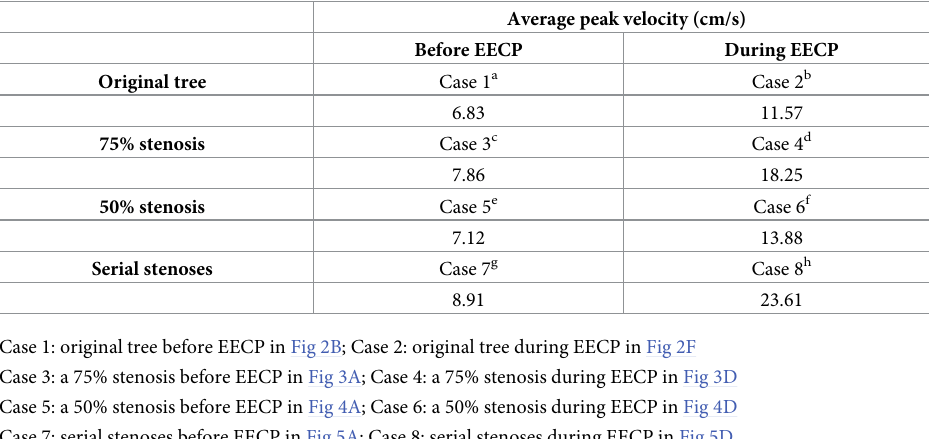
Table 2. Average peak velocity along the epicardial LAD main